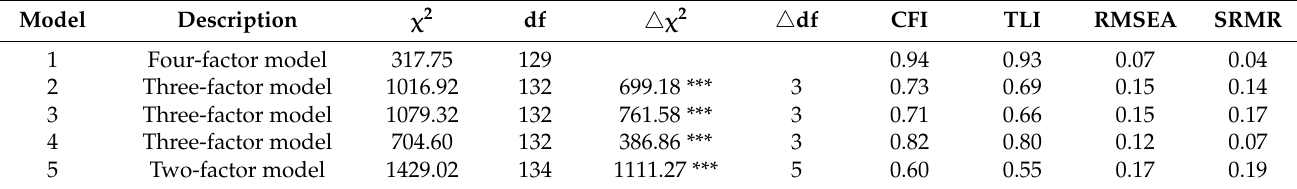
Table 1. Confirmatory factor analysis